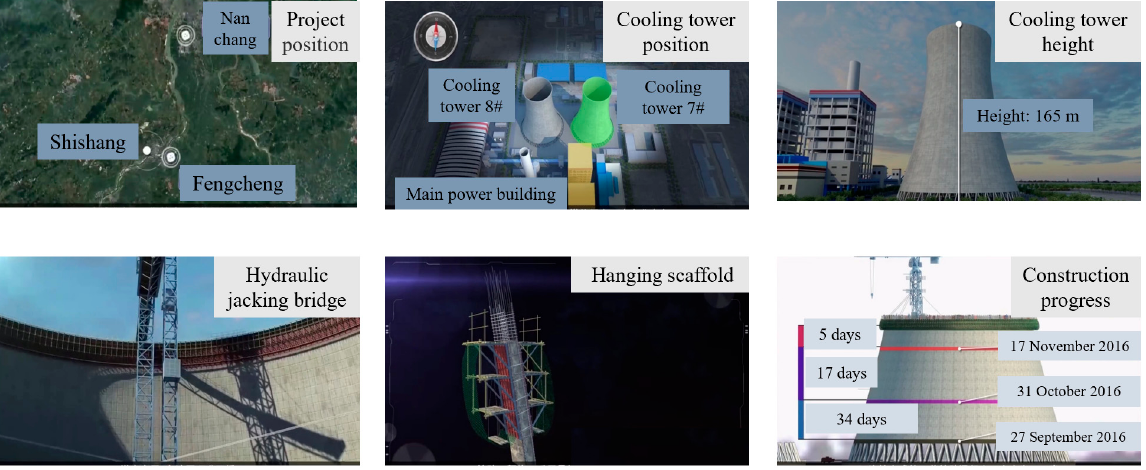
Figure 2. An overview of the cooling tower 7 project.